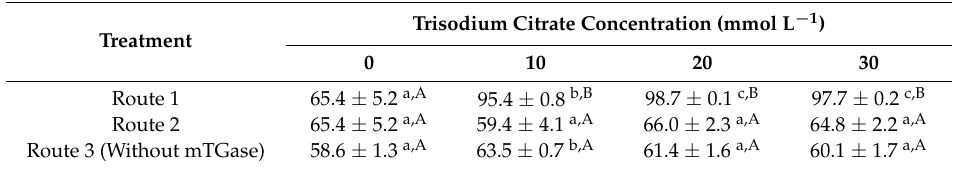
Table 3. The effects of trisodium citrate on the water holding capacity (%) of casein gels 1 .